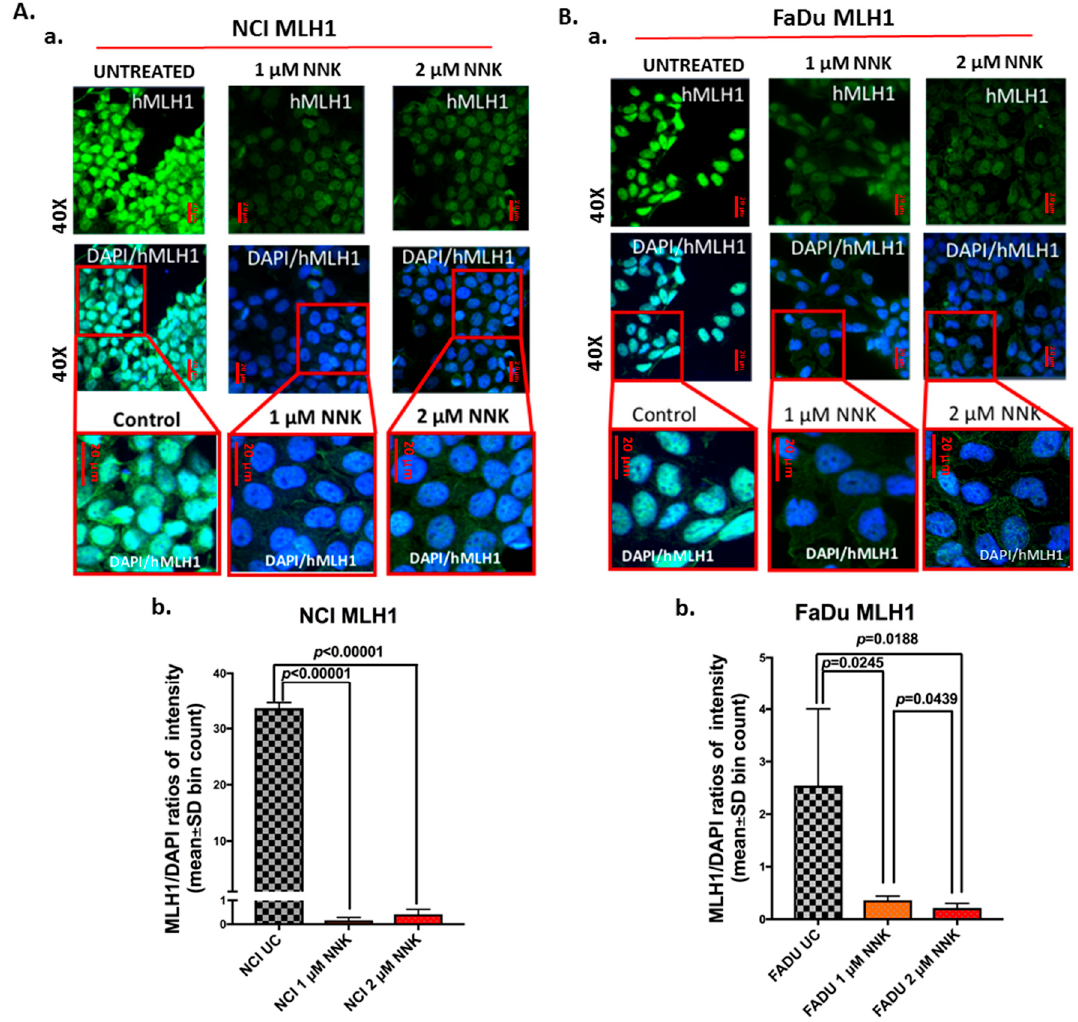
Figure 2. Either low or high dose of NNK reduce MLH1 expression in both lung (NCI) and head and neck (FaDu) cancer cells. Immunofluorescence staining for MLH1 reveals that ( A ) NCI and ( B ) FaDU exposed to either 1 µ M or 2 µ M of NNK produce reduced MLH1 nuclear levels, as indicated by ( A - a and B - a ) the weak nuclear staining of MLH1 (green: MLH1; blue: DAPI for nuclear staining; scale bar: 20 µ m), and ( A - b and B - b ) the significantly lower nuclear MLH1 levels [MLH1 / DAPI means(SD) bin count, by Zen imaging software], compared to untreated controls. Data were obtained from four independent images ( p values by t -test; multiple comparisons by Holm-Sidak; GraphPad Prism 7.0). Western blot analysis confirmed the above immunohistochemical analysis data. Specifically, as shown in Figure 3, both NCI and FaDu exposed to a low (1 µ M) or high (2 µ M) dose of NNK showed significantly lower MSH2 and MLH1 nuclear translocation ratios (nuclear vs. cytoplasmic levels) (Figure 3A-a,B-a) compared to untreated controls. In general, the high NNK dose induced lower nuclear translocation ratios of MMR proteins compared to the low dose (Figure 3A-b,B-b). NCI exposed to either a low or high dose of NNK produced a similar reduction of MSH2 and MLH1. In general, total MMR (MSH2 and MLH1) protein levels were significantly reduced in NNK-treated NCI and FaDu, relative to their untreated controls (Supplementary Figure